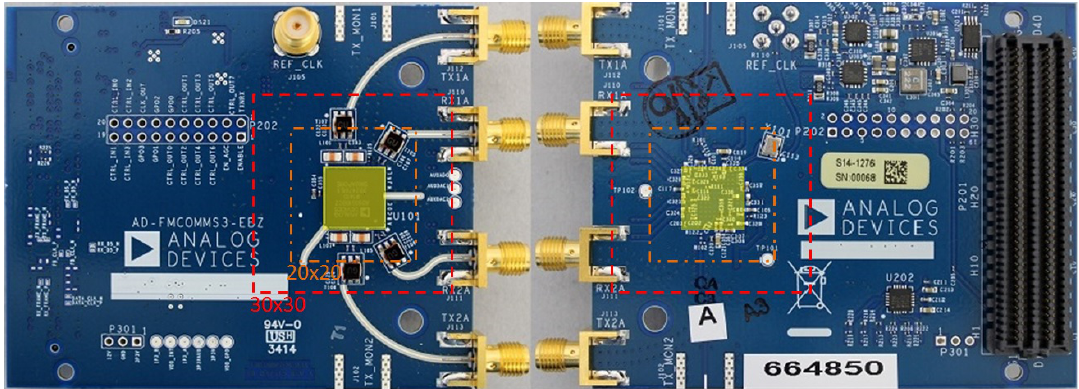
Figure 5. Top ( left ); and bottom ( right ) view of the DUT test